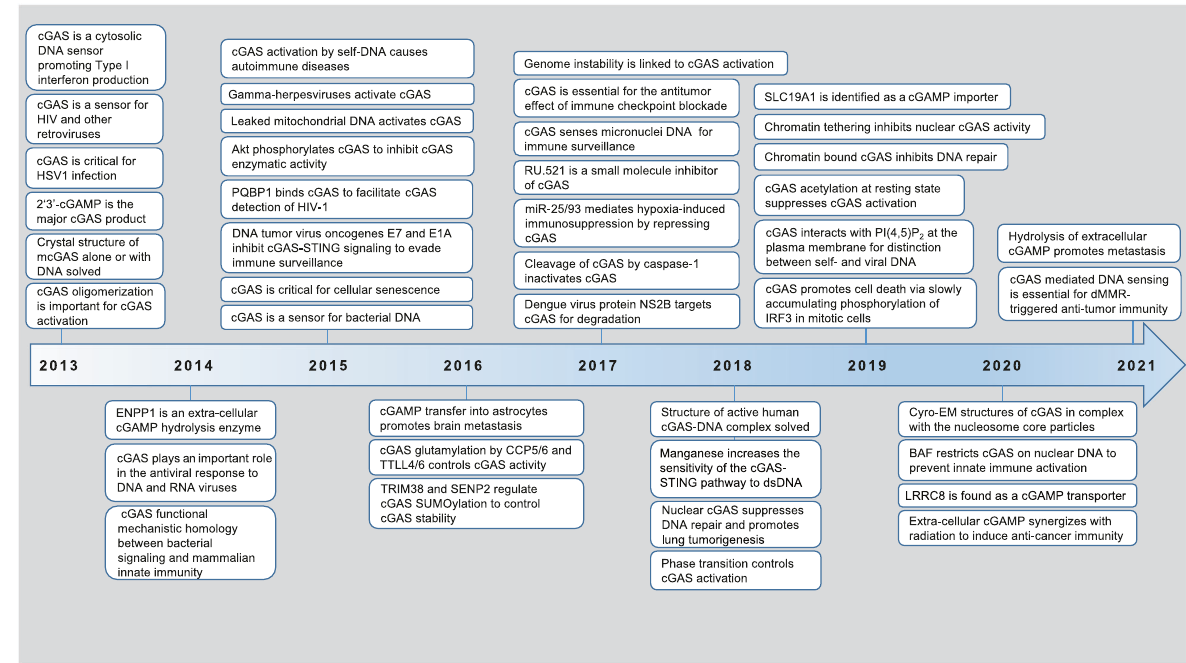
Fig. 1 A timeline for discoveries of cGAS regulation and function. Due to a large amount of work on this topic in the past 8 years, we cannot include all major fi ndings in this time table and we sincerely apologize for colleagues whose important work are not mentioned in this fi gure due to space